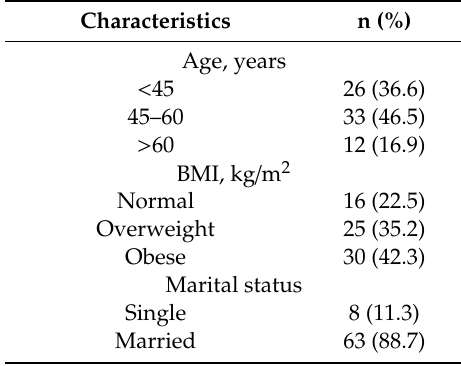
Table 1. Demographics and clinicopathologic characteristics of breast cancer patients (n =